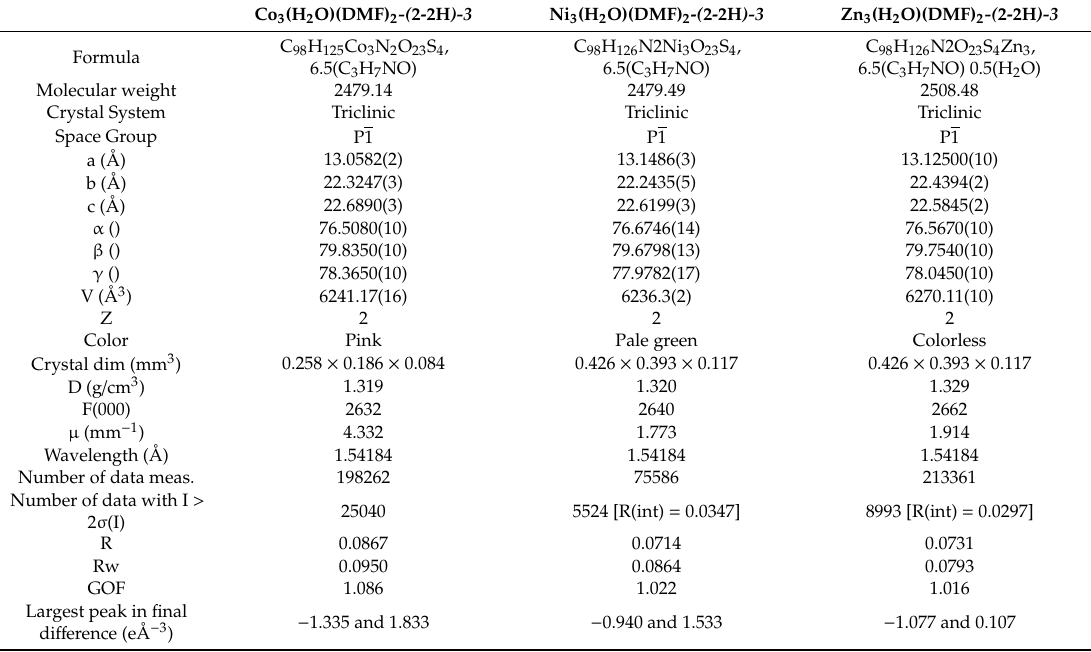
Table 1. Crystallographic data for Co 3 (DMF) 2 - 2 - 3 , Ni 3 (DMF) 2 - 2 - 3 and Zn 3 (DMF) 2 - 2 - 3